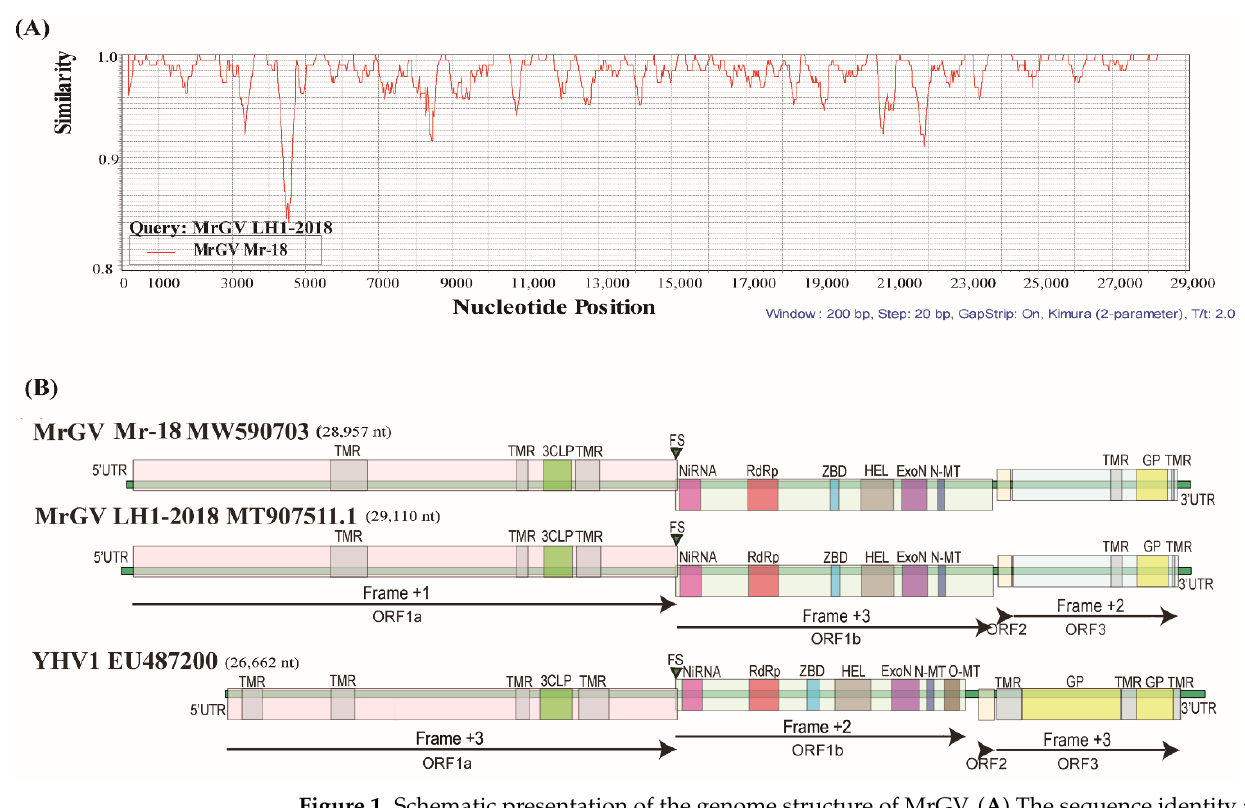
Figure 1. Schematic presentation of the genome structure of MrGV. ( A ) The sequence identity and ( B ) the conserved protein domains of yellow head virus (YHV), Macrobrachium rosenbergii golda virus (MrGV) Mr-18, and MrGV LH1-2018. TMR: Transmembrane region; 3CLP: 3C-like protease;